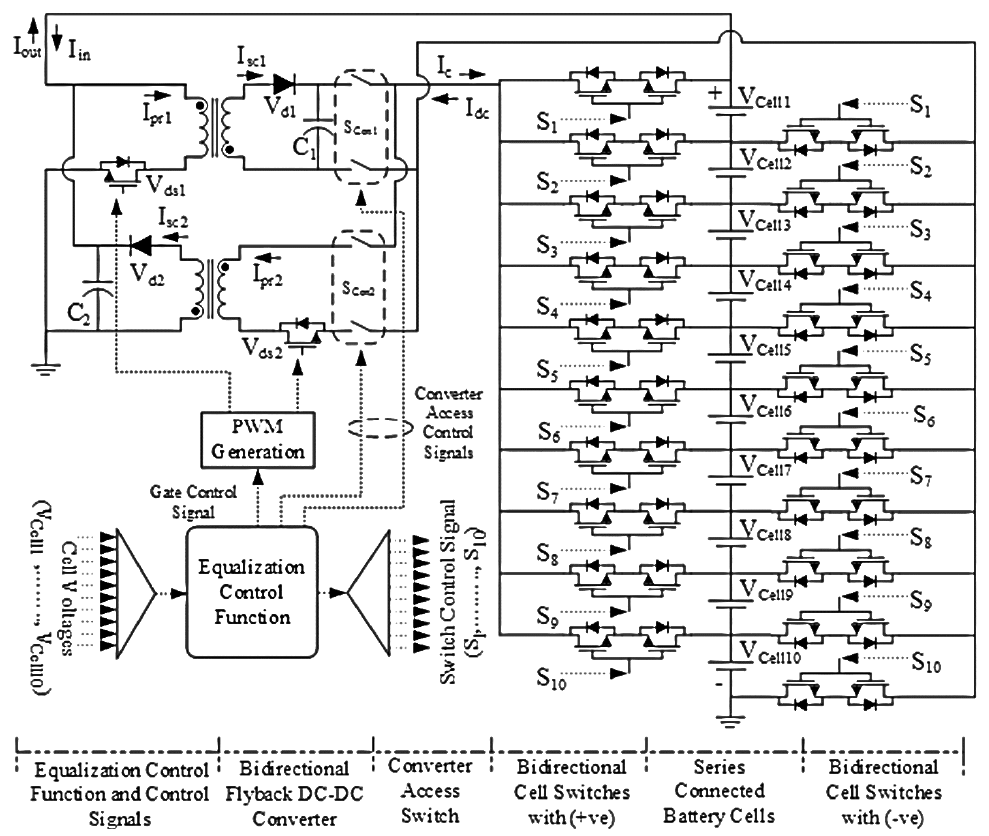
Figure 1. Circuit model of a charge equalization controller.